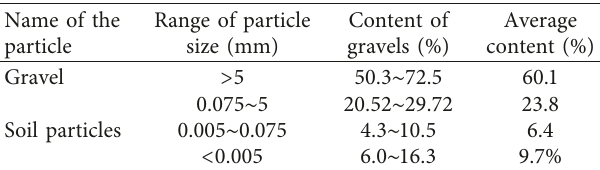
Table 2: Particle composition of samples after scalping. Name of